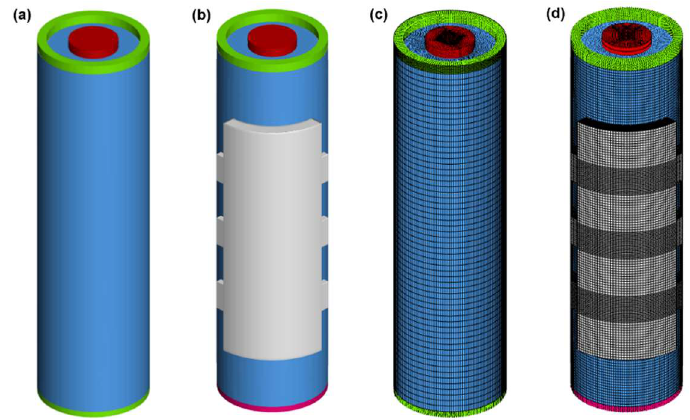
Figure 1. Geometric model of ( a ) lithium-ion single cell or HF heated cell; ( b ) microchannel cooled water heated cell; ( c ) grid schematic of lithium-ion single cell; ( d ) microchannel cooled water heated cell. Table 2. Physical parameters for cell modeling.